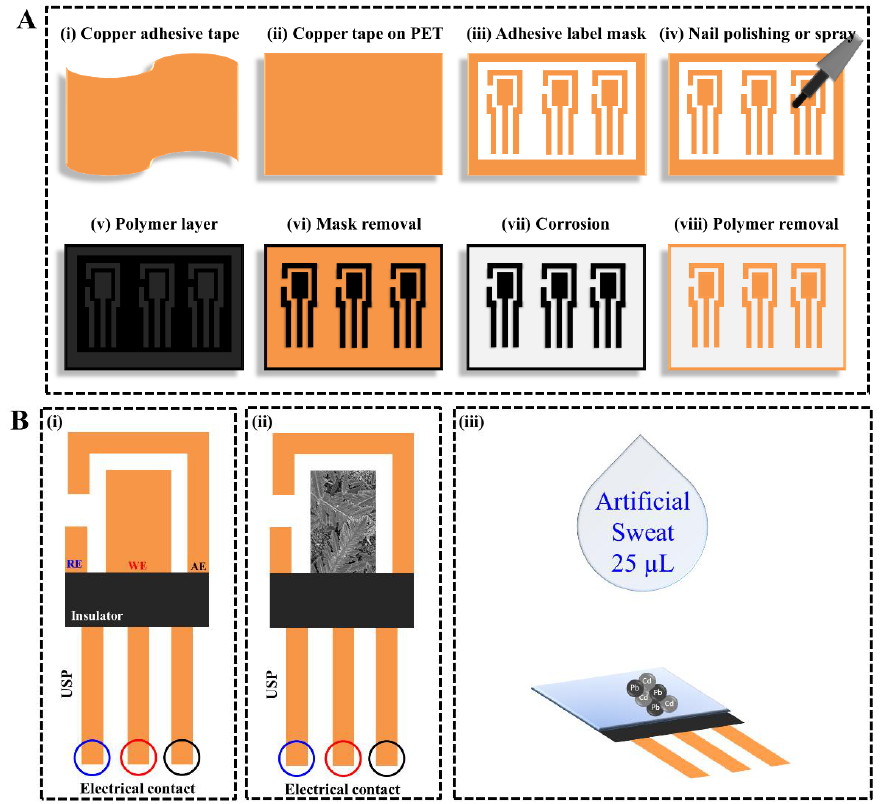
Figure 1. Schematic representation of the design and fabrication of a flexible copper sensor decorated with bismuth micro/nanodentrites. ( A ): (i) conductive copper adhesive tape; (ii) copper adhesive